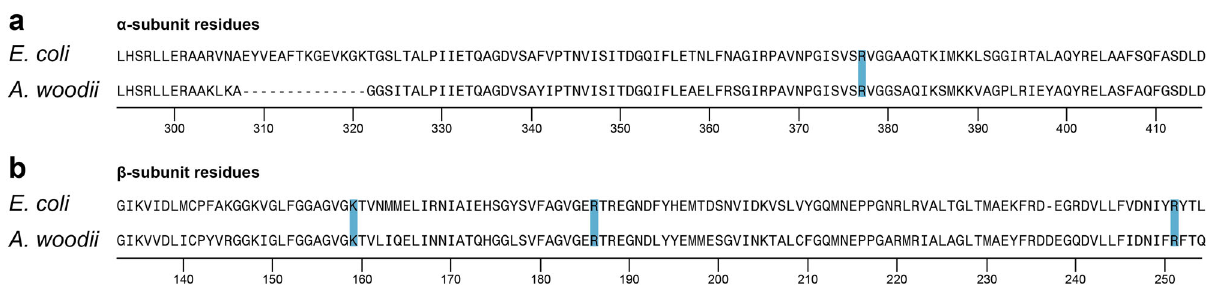
Fig. 5 Amino-acid sequence alignment of α - and β -subunit residues for E. coli and A. woodii . a α -subunit residues. b β -subunit residues. Positions of positively charged amino acids that were mutated are marked in blue.